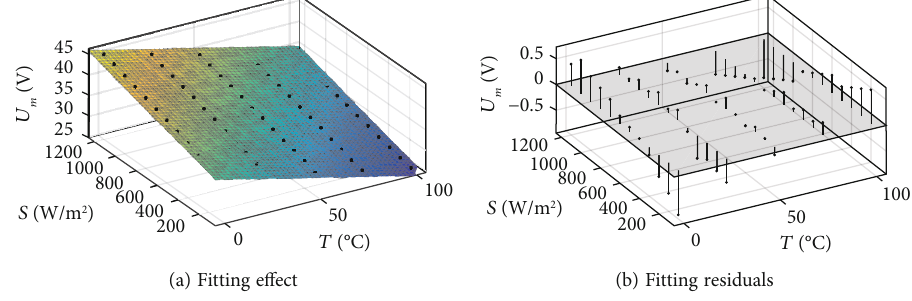
Figure 7: Curve fi tting with Equation (8).